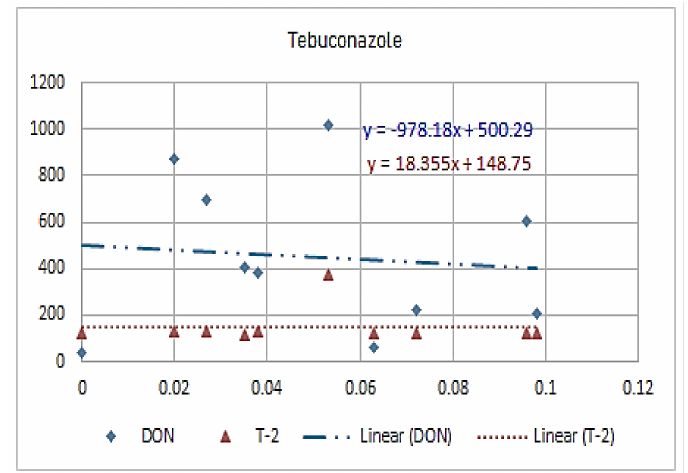
Figure 6. The relation between tebuconazole residue (ppb) and DON and T-2 toxin (ppb) in wheat samples.